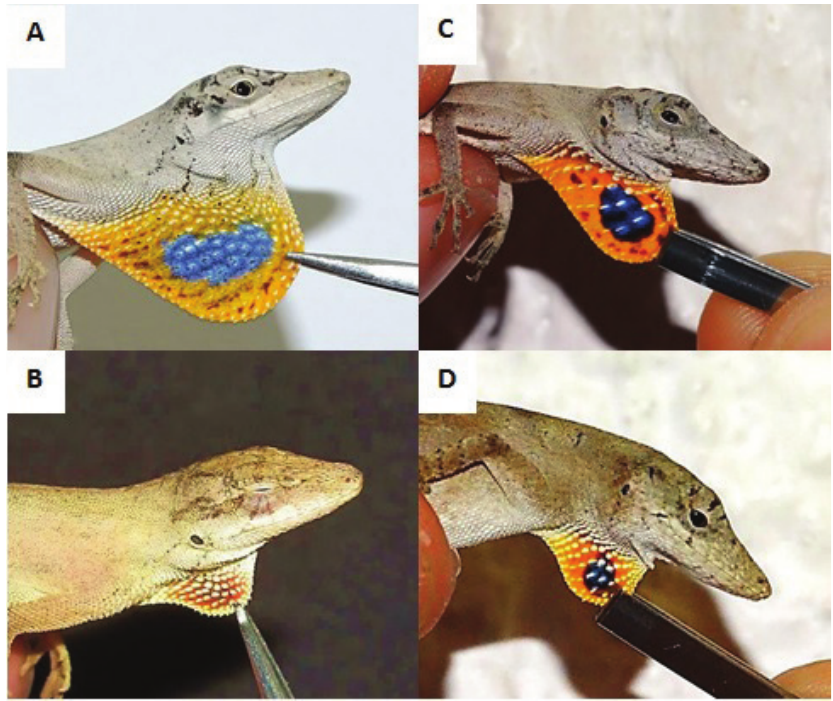
Figure 7. Dewlaps. A male from AV, photo by Ismael Reaño Hernández B female from AV, photo by Luis M. Badillo Saldaña C male from YP D female from